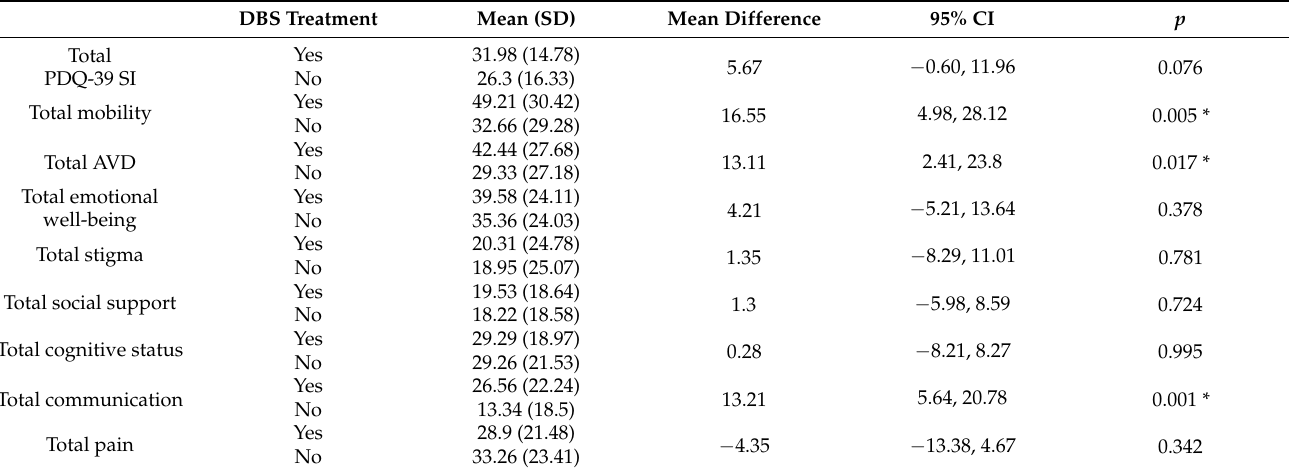
Table 7. Differences among the total scores for the PDQ-39 domain scores in the patients who had and had not undergone